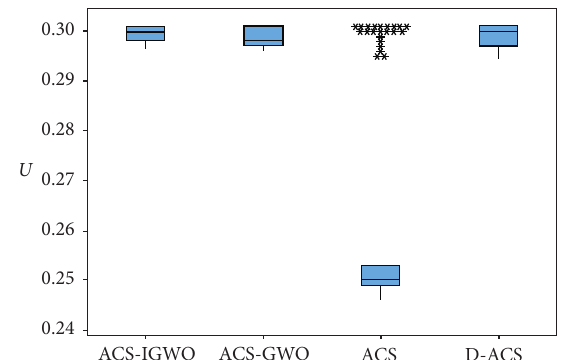
Figure 11: Box plot of example III.